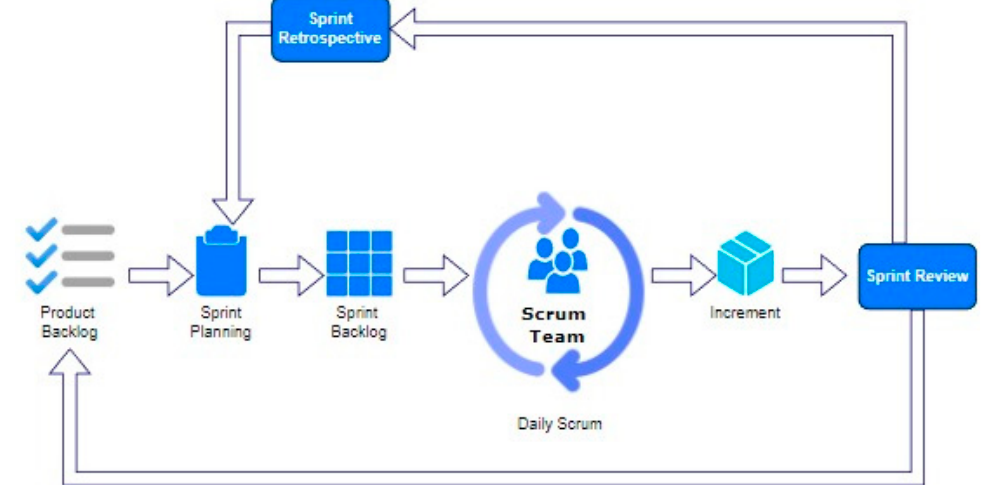
Figure 3. Agile Development—Scrum.